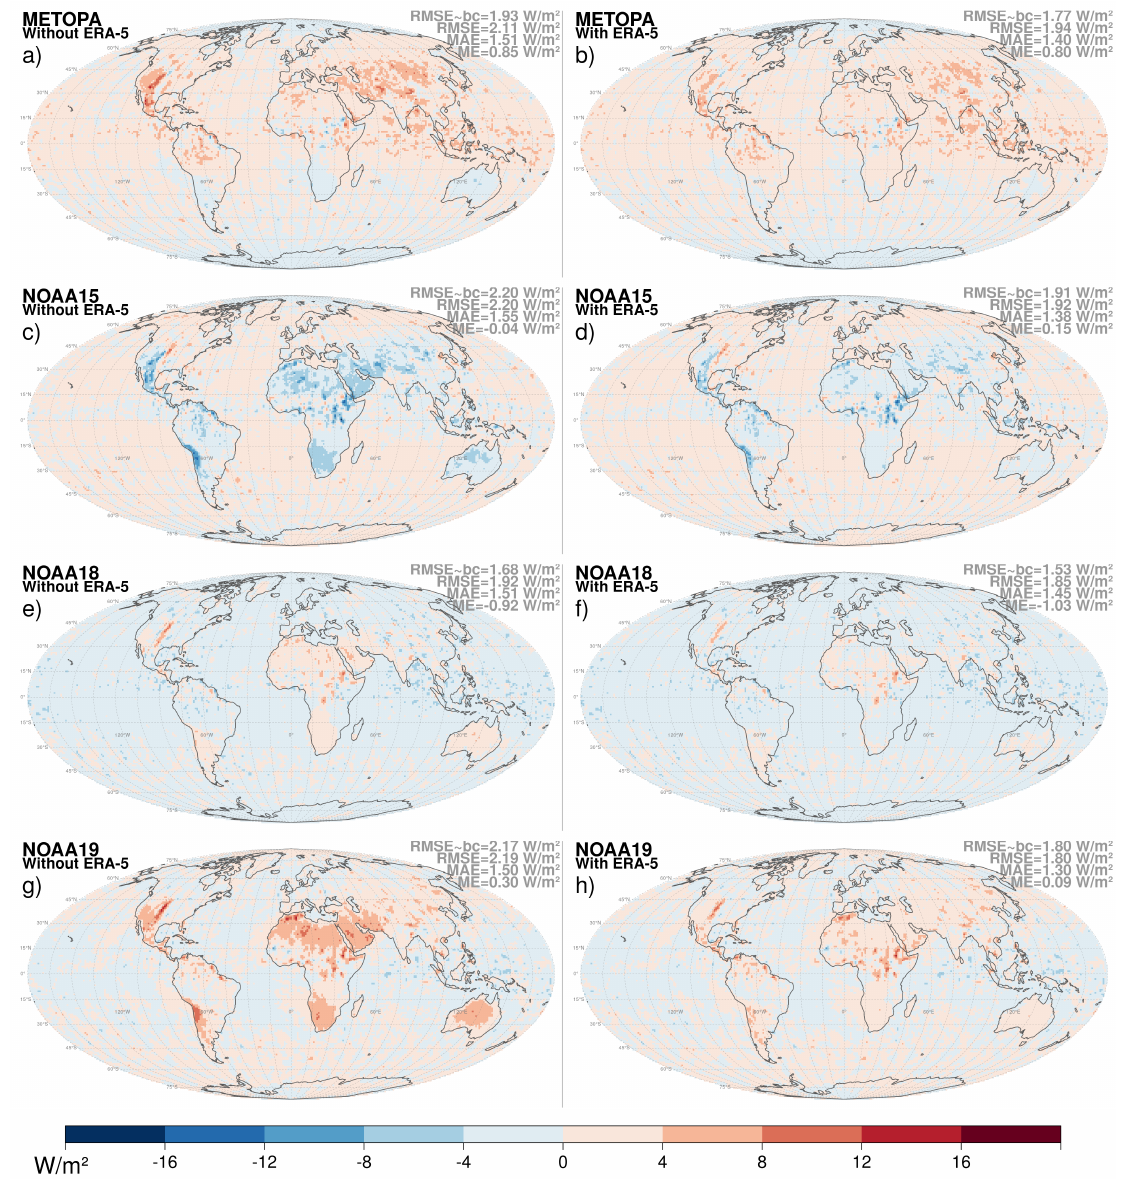
Figure 6. Difference between the June 2012 monthly mean OLR calculated by using the individual satellites and the reference (calculated using all available satellites), with figure rows representing satellites METOP-A ( a , b ), NOAA-15 ( c , d ), NOAA-18 ( e , f ) and NOAA-19 ( g , h ). The columns distinguish linear temporal interpolation ( left ) and ERA5 diurnal cycle modeling over clear land pixels ( right